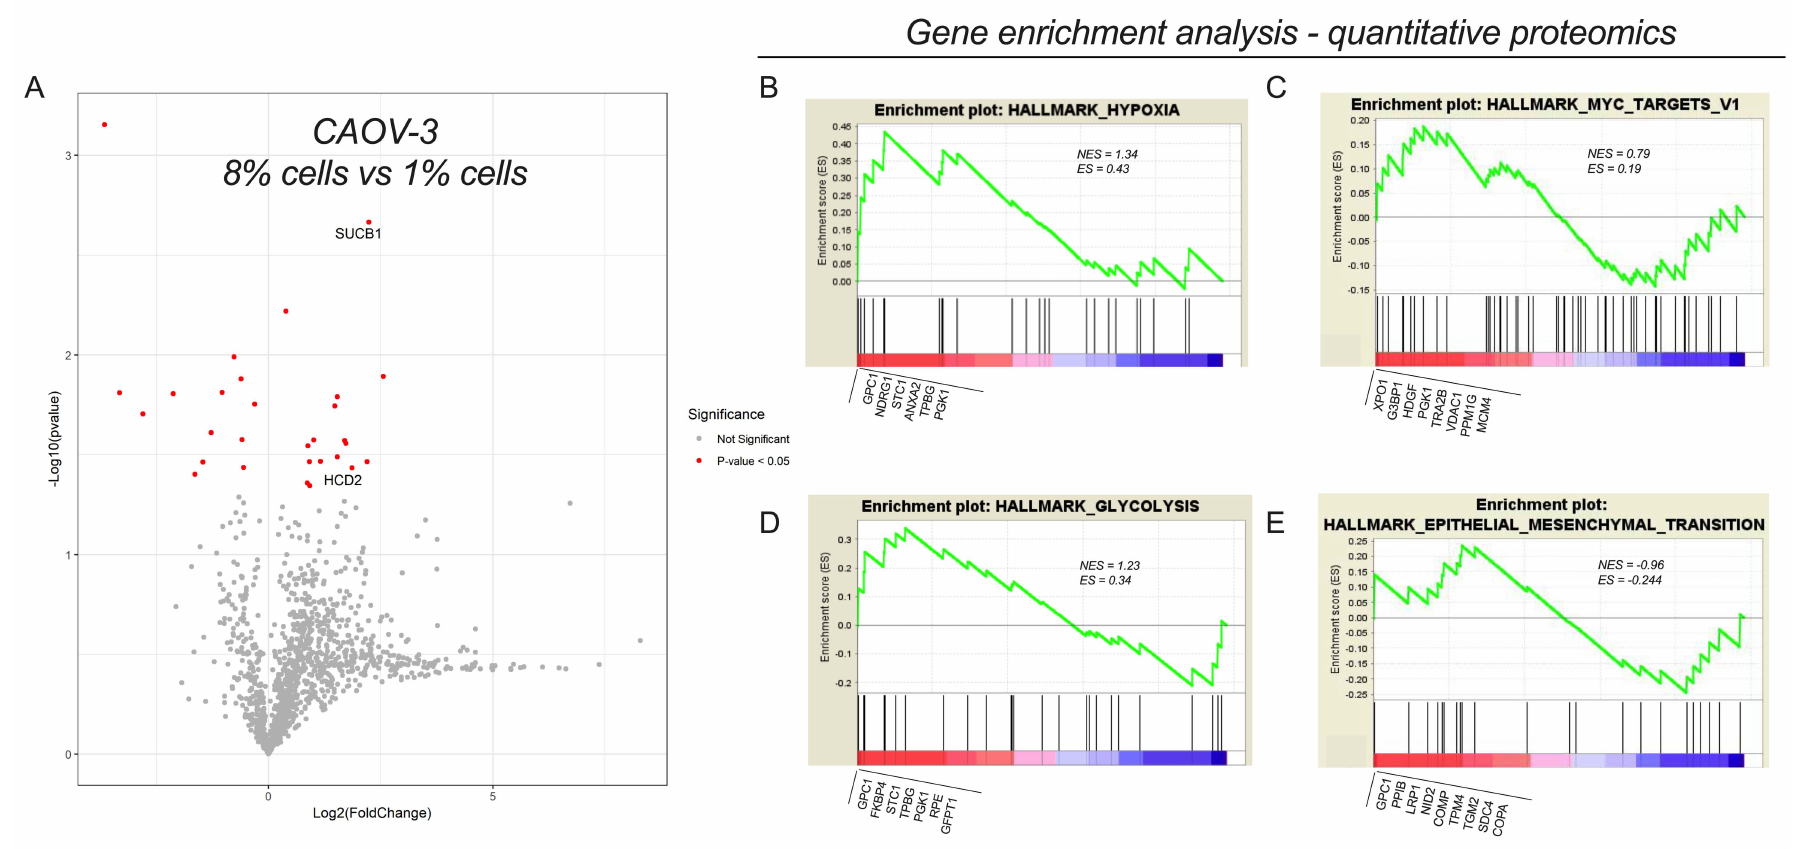
Figure 2. Quantitative proteomic analysis of CAOV-3 cells exposed to 1% O 2 and 8% O 2 . ( A ). Volcano plot of the quantified proteins showing the differentially expressed proteins in the CAOV-3 cells exposed to 1% oxygen tension compared with cells exposed to 8% oxygen tension (upregulated on the right side and downregulated on the left side). 30 proteins were significantly expressed in the hypoxic cells (1% O 2 CAOV-3) than in the normoxic cells. Gene set enrichment analysis (GSEA) of proteomic data illustrate four gene clusters that are enriched in the 1% O 2 CAOV-3 cells compared cells at 8% O 2 namely, ( B ) hypoxia, ( C ) epithelial–mesenchymal transition, ( D ) glycolysis, and ( E ) Myc target genes. The protein subset was evaluated using the normalized enrichment score (the green line). In the GSEA figures, the black vertical lines identify the positions where the members of a particular pathway appear in the ranked list of genes. The upregulated genes in red are localized on the left, while the downregulated proteins in blue are on the